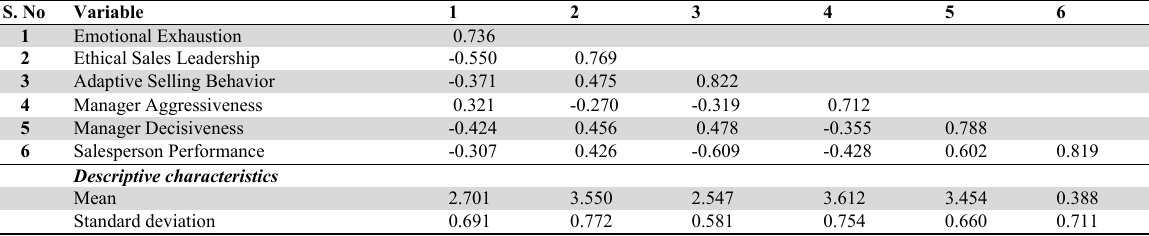
Descriptive statistics, correlation and, discriminant validity.